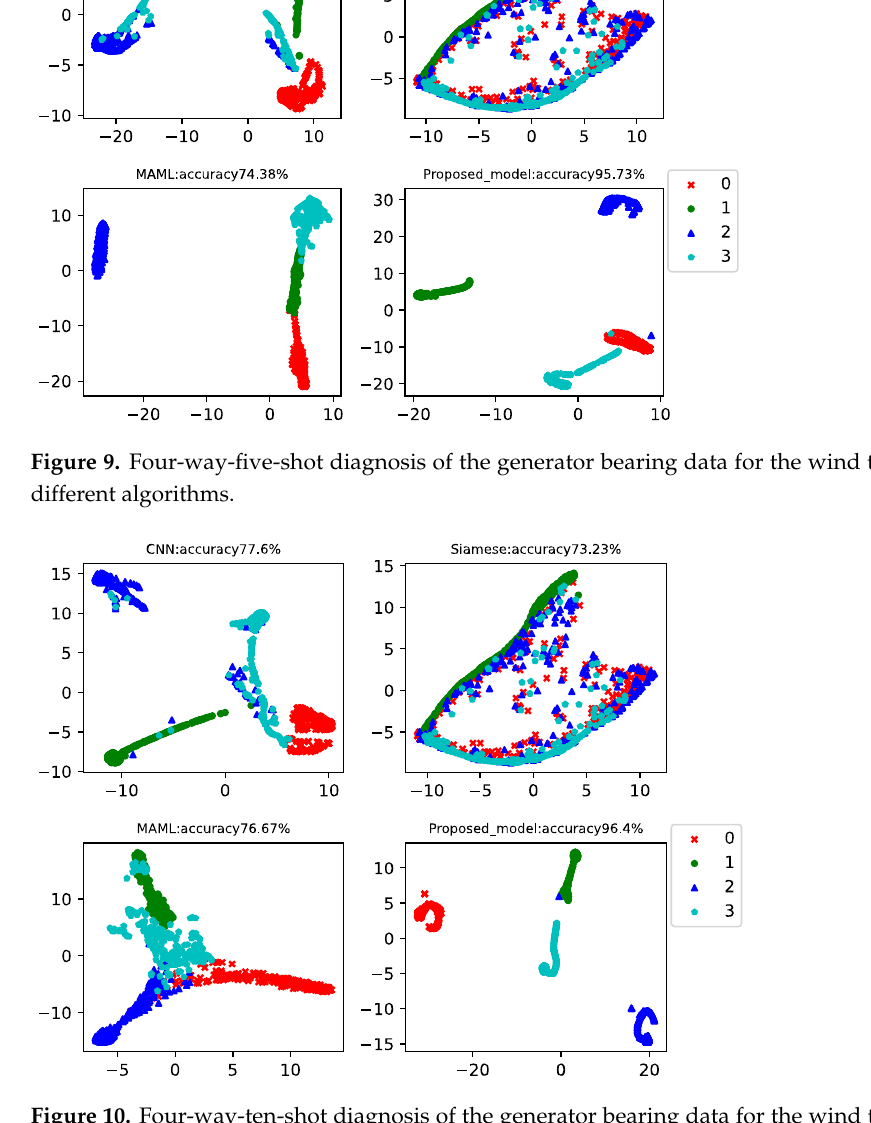
Figure 10. Four-way-ten-shot diagnosis of the generator bearing data for the wind turbines using different algorithms.